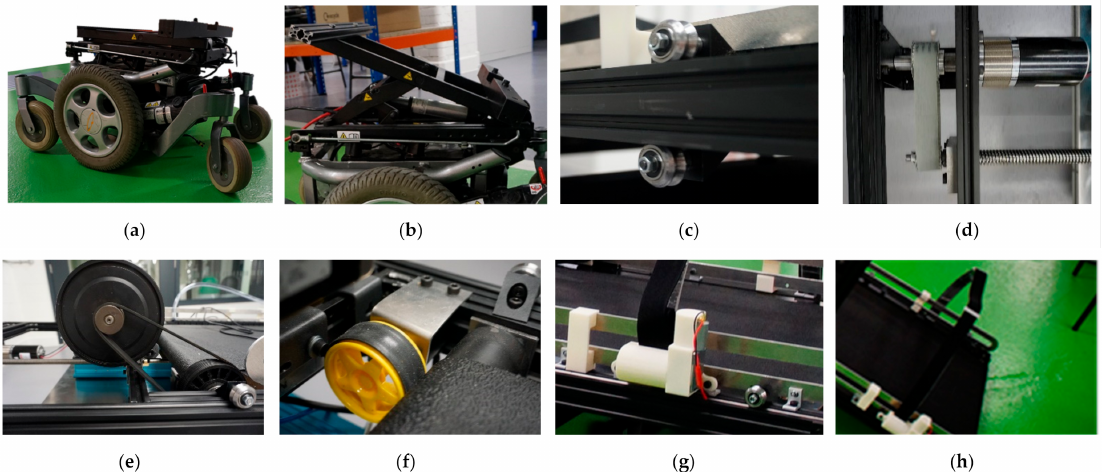
Figure 11. ResQbot 2.0 main modules. ( a ) Differential-drive mobile base module. ( b ) Stretcher bed tilting module. ( c ) The bed’s sliding-rail mechanism. ( d ) The motor drive and the lead-screw mechanism that enable the stretcher bed to slide. ( e ) The motor drive and transmission system of the conveyor module. ( f ) The rotary encoder of the conveyor module, which allows feedback control to synchronise the conveyor and mobile base speed during the casualty loading process. ( g ) DC motor to drive the strap fastening and securing mechanism. ( h ) The stretcher strap module attached to the stretcher